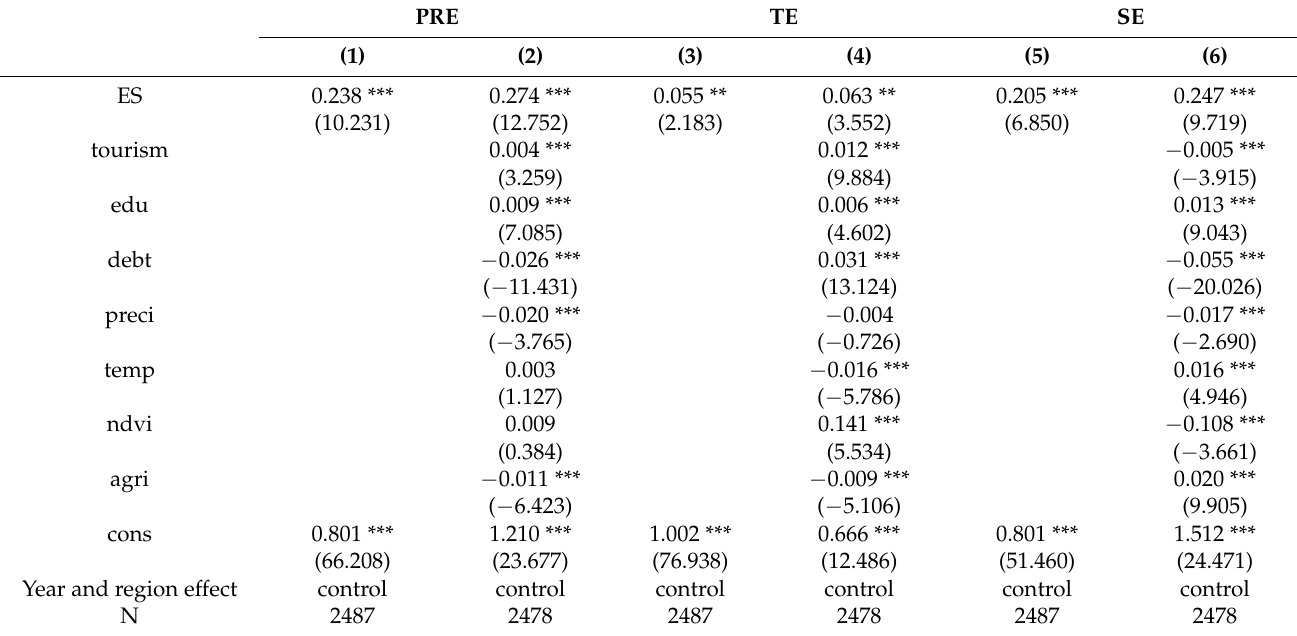
Table 3. National PRE and ecological service value: benchmark